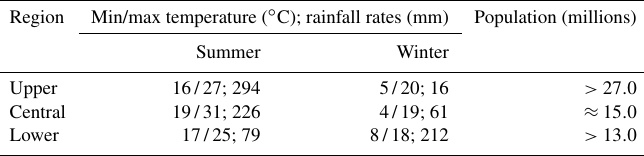
Table 2. Summarised information on the meteorology and population characteristics of the